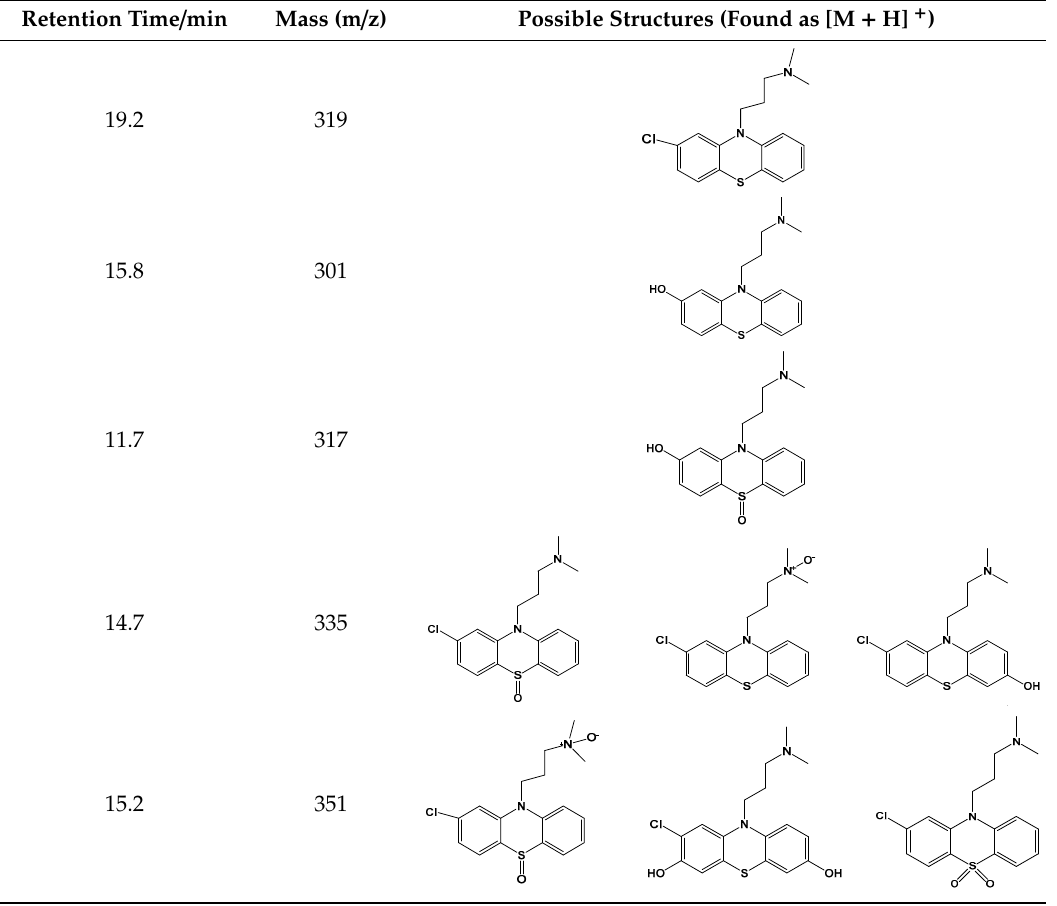
Table 1. Chlorpromazine and some of the reaction intermediates of its photocatalytic and photolytic conversion under aerobic conditions, their retention times, masses, and possible structures.